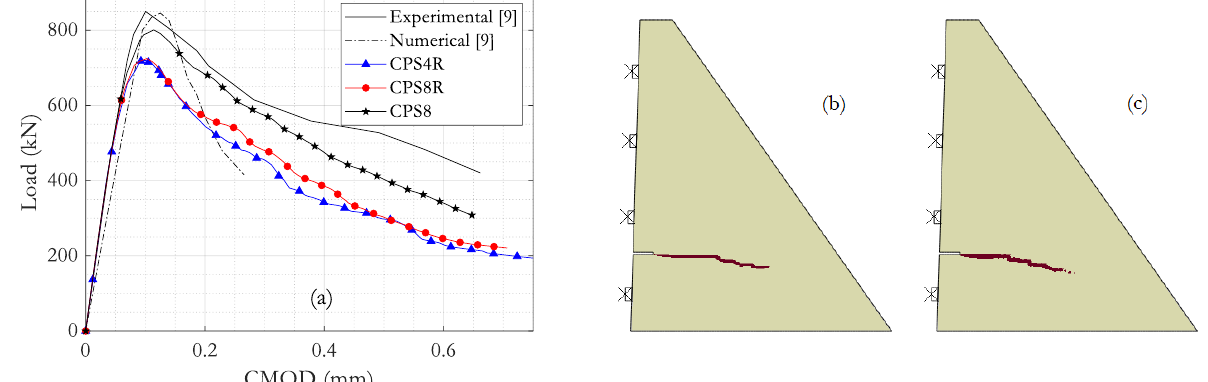
Figure 8. ( a ) Load-CMOD curve for mesh 1 using linear and quadratic finite elements, and the corresponding crack trajectory for the higher-order mesh using ( b ) CPS8R and ( c ) CPS8 elements.